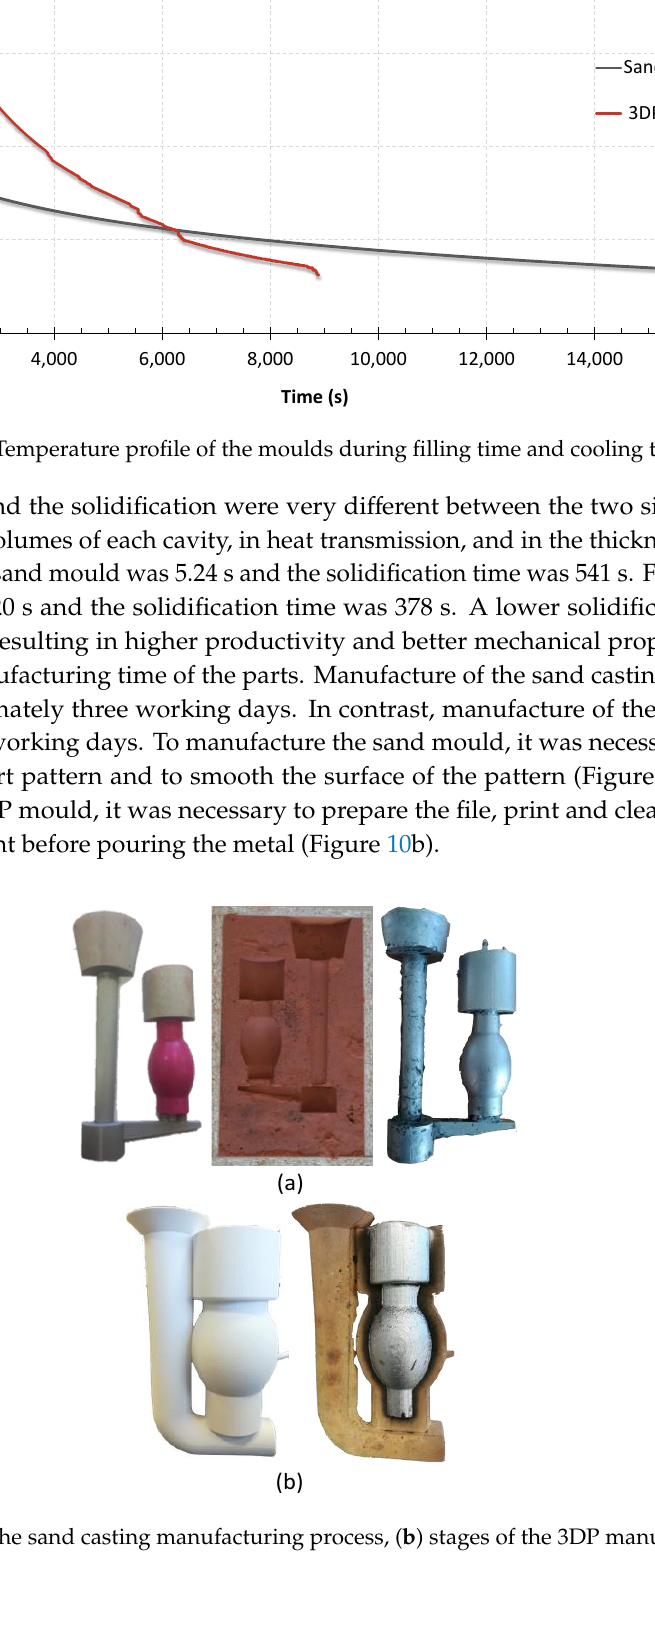
10 of 18 Figure 8. Casting temperature profile for both parts after ending the filling process: ( a ) sand casting. ( b ) 3DP casting. The filling time and the solidification were very different between the two simulations due to the differences in the volumes of each cavity, in heat transmission, and in the thickness of the moulds. The filling time for the sand mould was 5.24 s and the solidification time was 541 s. For the 3DP mould, the filling time was 2.20 s and the solidification time was 378 s. A lower solidification time means a faster cooling ratio, resulting in higher productivity and better mechanical properties of castings. Table 4 shows the manufacturing time of the parts. Manufacture of the sand casting part